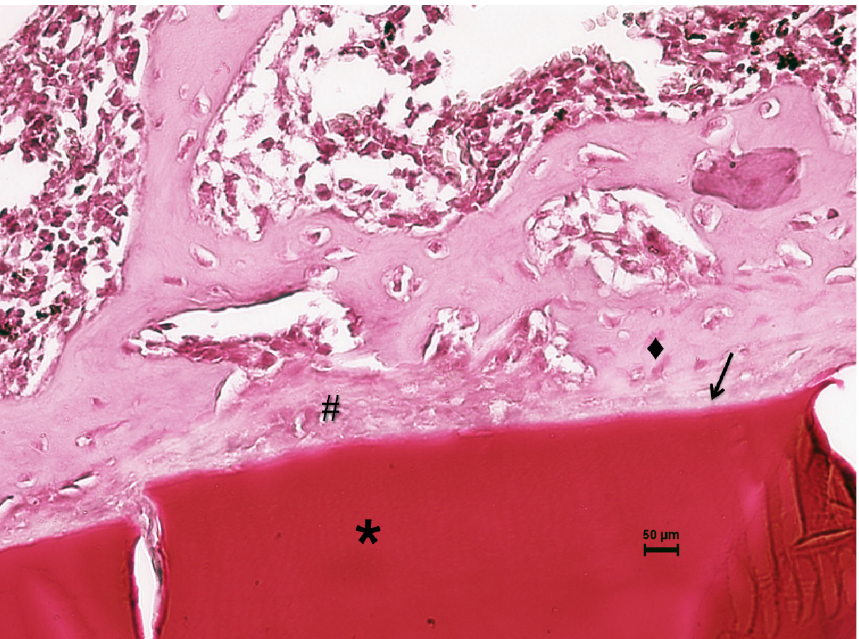
Figure 8. Histological evaluation of CS at 14 days post-implantation. At the tissue–biomaterial interface there is reparative granulation tissue (#) and formation of woven bone tissue ( ♦ ), sometimes in close contact with the surface of the biomaterial (osseointegration ↑ ). Orig. Mag. ×400; H-E stain. * Pure chitosan (CS).